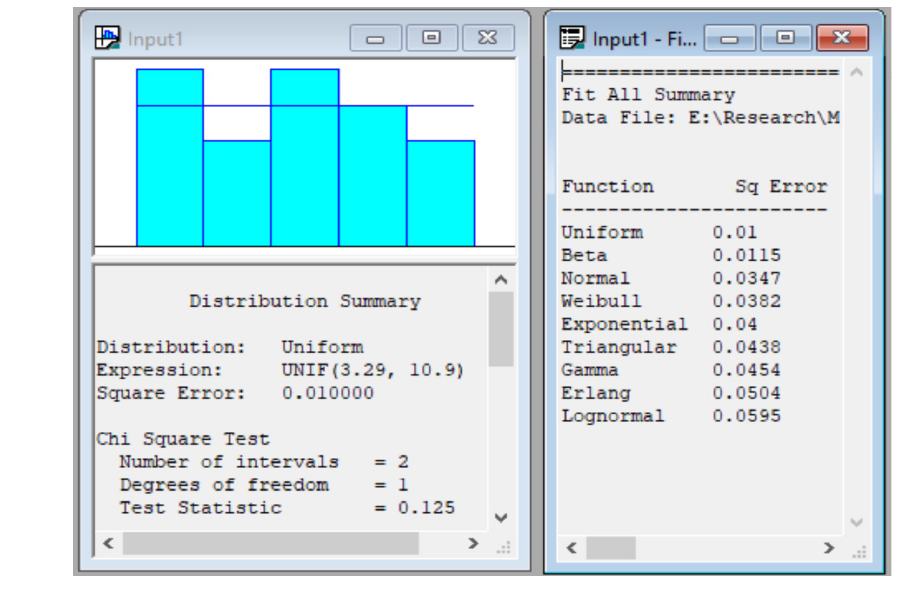
FIG. 7. DISTRIBUTION OF SERVED PATIENTS BY